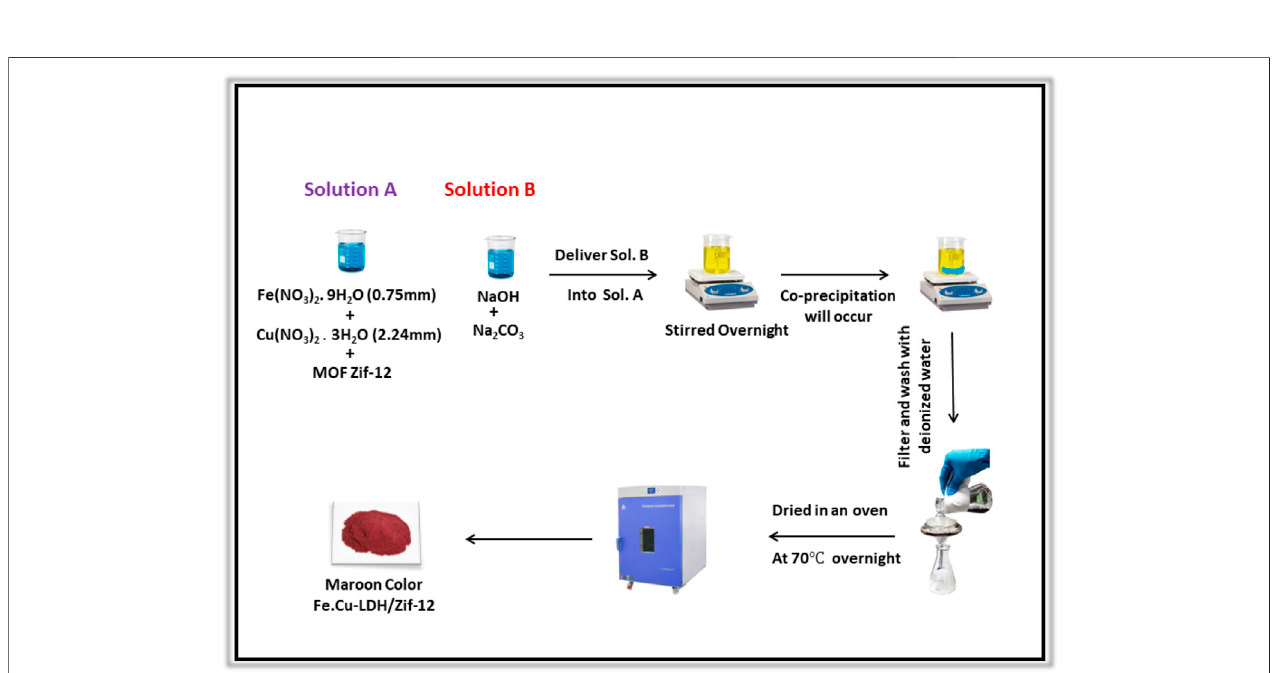
SCHEME 1 | Schematic illustration of the synthesis of